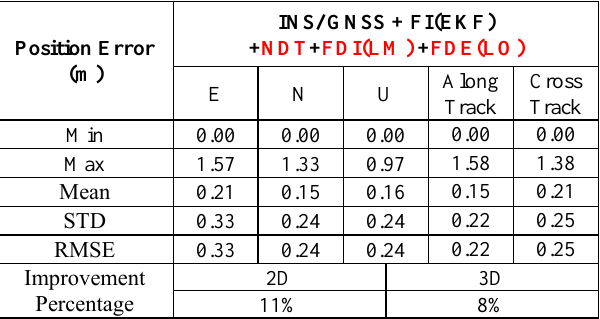
Table 6 . Performance analysis of initial pose with NDT and Fault detection, isolation, and exclusion scheme.